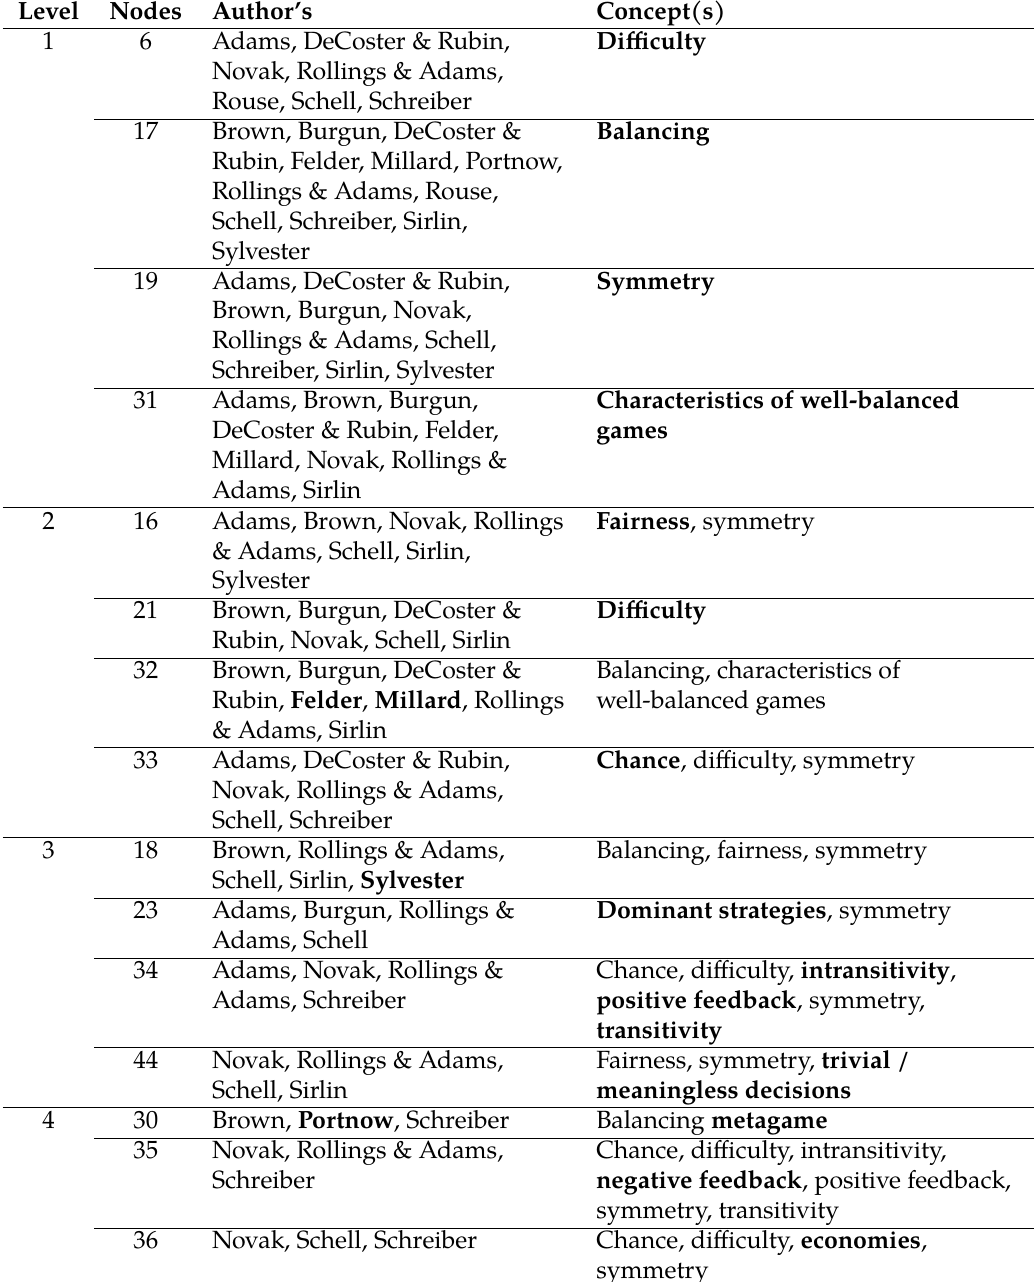
Table 2: Descriptions for Fig. 1. Nodes are sorted by the level they appear on, from top to